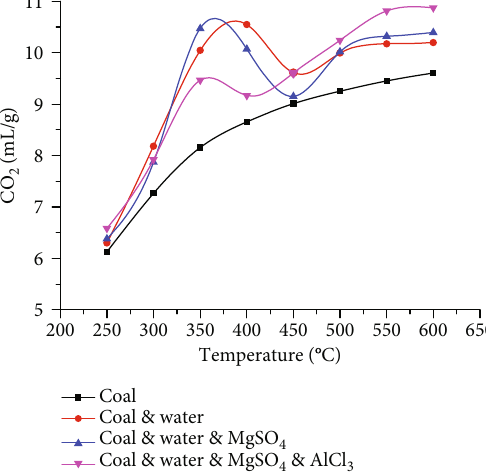
Figure 4: Variation characteristics of methane production.